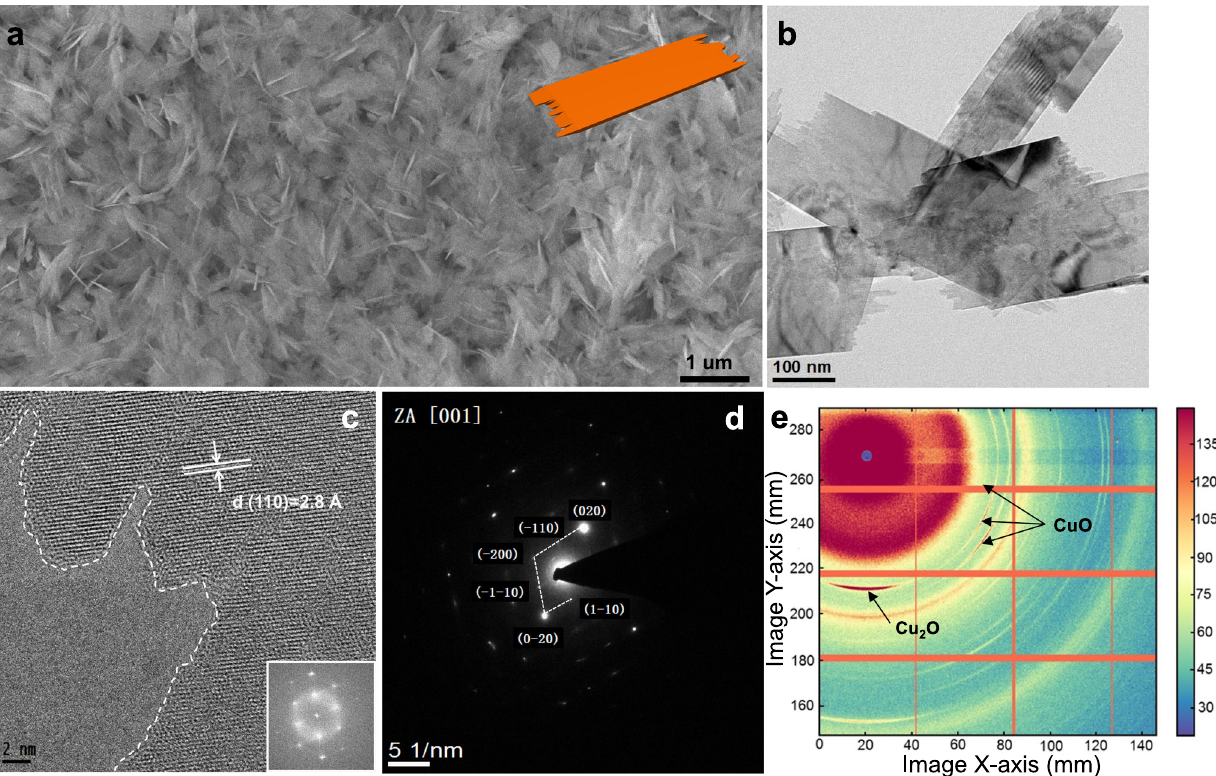
Fig. 1 Morphological, structural characterizations of sheet-like CuO catalysts synthesized in this study by ex situ techniques. a Large-scale scanning electron microscopy (SEM) image and 3D structure of CuO NS (insert, orange). b Transmission electron microscopy (TEM) image and c high resolution TEM (HR-TEM) images with measured lattice distance and the corresponding fast Fourier transformation. d Selected area electron diffraction (SAED) pattern along zone axis [001]. e 2D Synchrotron grazing incidence wide-angle X-ray scattering (GI-WAXS) image demonstrating preferred orientation